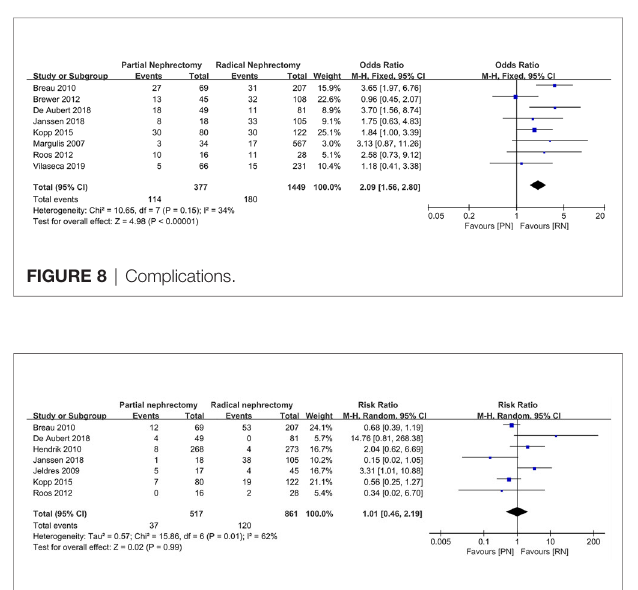
FIGURE 9 | Cancer-speci fi c mortality.